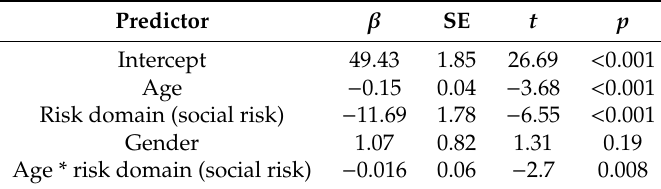
Table 4. Estimates from the model predicting risk